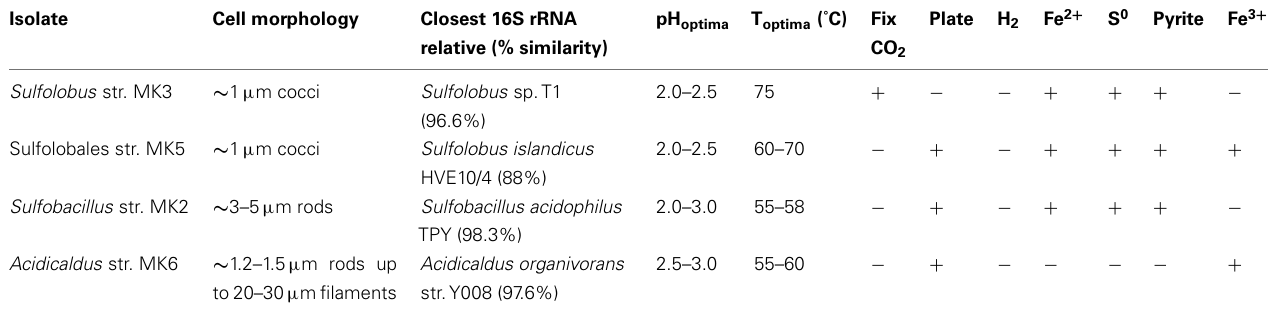
Table 3 | Novel isolates obtained from acid-sulfate-chloride (ASC) springs and characterization of cell morphology, pH optima, temperature optima, and growth on iron and sulfur substrates as electron donors or Fe(III) as an electron acceptor under anaerobic conditions. Isolate Cell morphology pH optima T optima (˚C) Fix Sulfolobus str. MK3